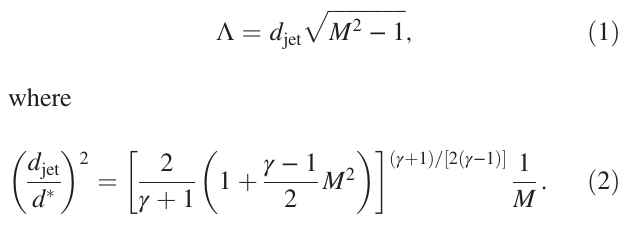
FIG. 3. Numerical calculations using the CFD module of COMSOL of the flow parameters for nozzle 1 and nozzle 2. The color bar indicates the Mach number of the gas flow. The velocity, temperature, and density along the central jet line are shown. P ¼ 300 mbar, T ¼ 300 K, and d (cid:2) ¼ 1 mm. (a) Nozzle 1: P 0 0 P ¼ 4 . 6 mbar, x ¼ 4 . 9 bg exit an angle β ¼ arcsin ð 1 =M Þ with the flow direction [50]. The period Λ is an axial distance needed for a disturbance to